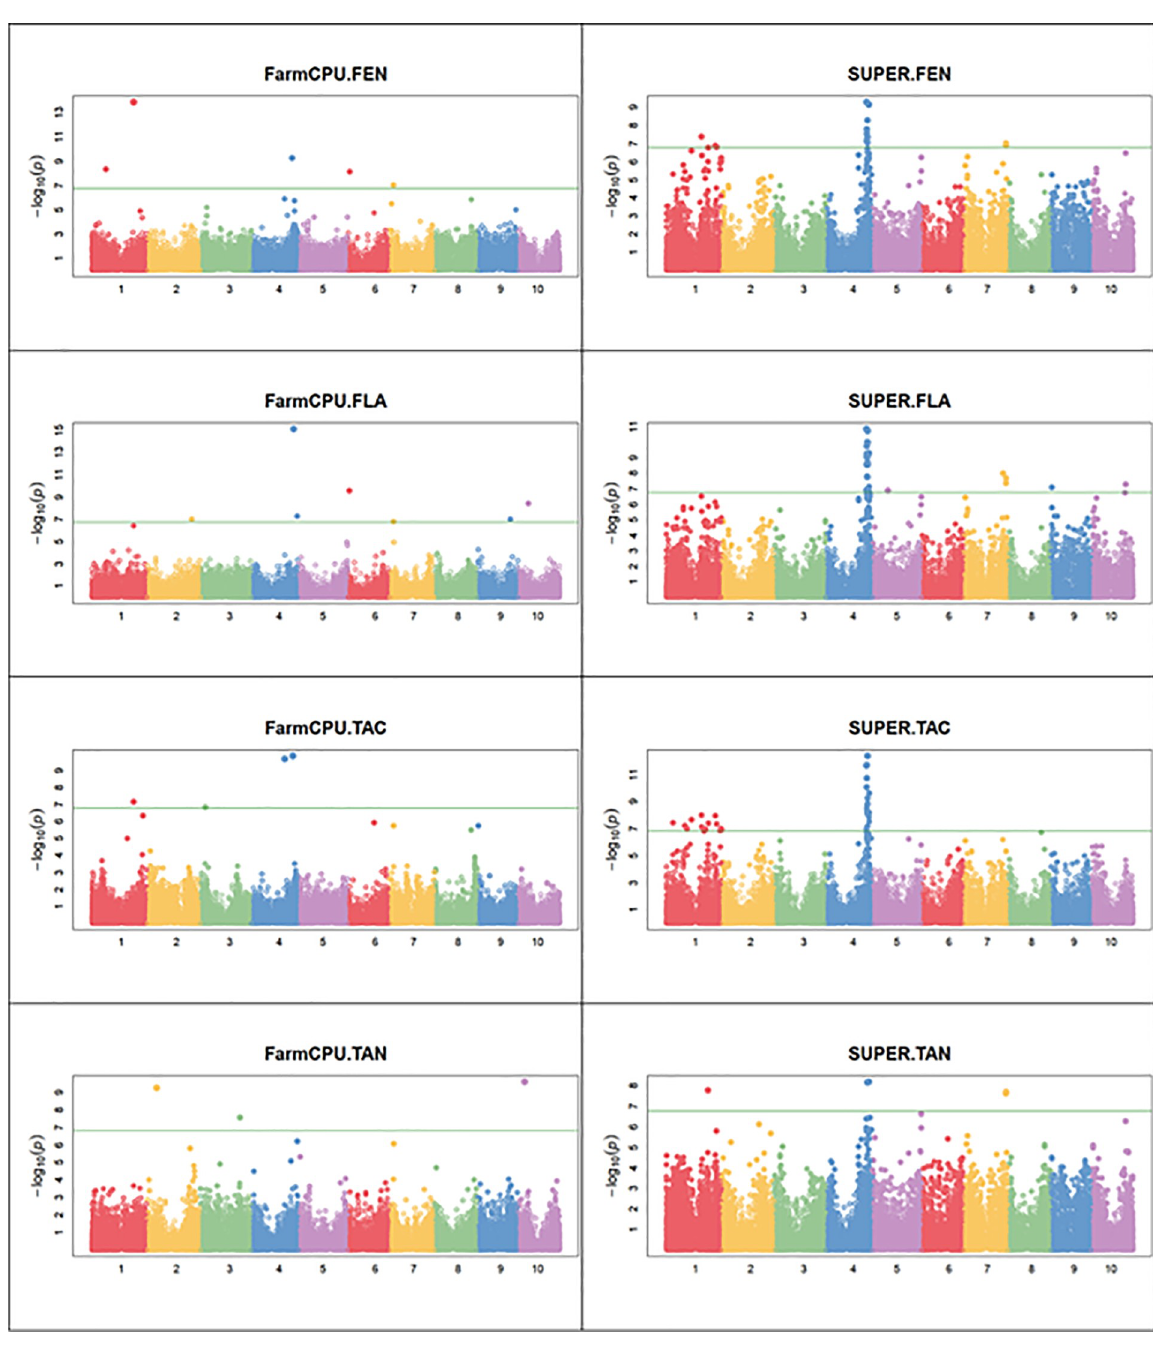
Fig 8. Manhattan plots representing several strongly associated antioxidant loci for the antioxidant traits. Each circle in the scatter plot represents a SNP, with the X-axis showing genomic location. Numbers 1 to 10 on X-axis represent the ten Sorghum bicolor chromosomes . The Y- axis shows the association level: -log10(P) is the negative base 10 logarithm of the P-values (probability of type-I error made in GWAS hypotheses testing). The solid horizontal line represents the genome-wide significance threshold as explained in the text. Regions with − log10 p-values above the threshold are candidates as in Table 2. Each plot shows the output of an algorithm for a specific target trait in the form “algorithm.trait”. TAN, TAC, FEN, FLA, respectively, condensed tannins, total antioxidants, phenols, and flavonoids. Refer to text for the description of the SUPER and FarmCPU